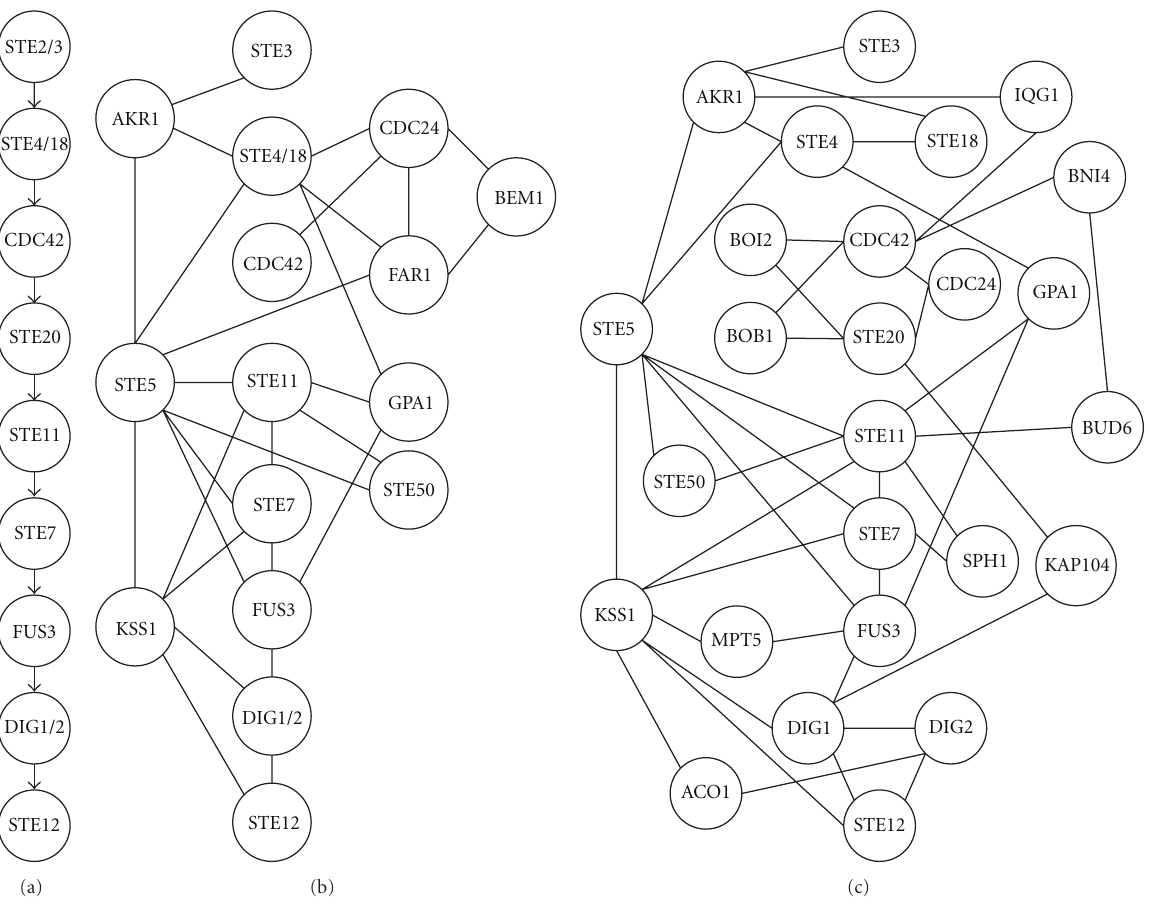
Figure 5: (a) The main chain path of pheromone response pathway (b) the assembly paths detected by Scott et al. method (c) the assembly paths detected by our